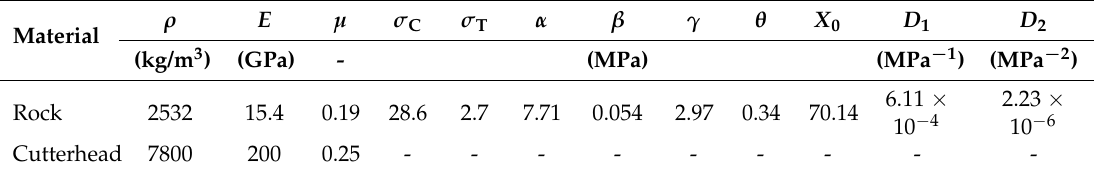
Table 1. Main parameters of the rock and cutterhead [34].